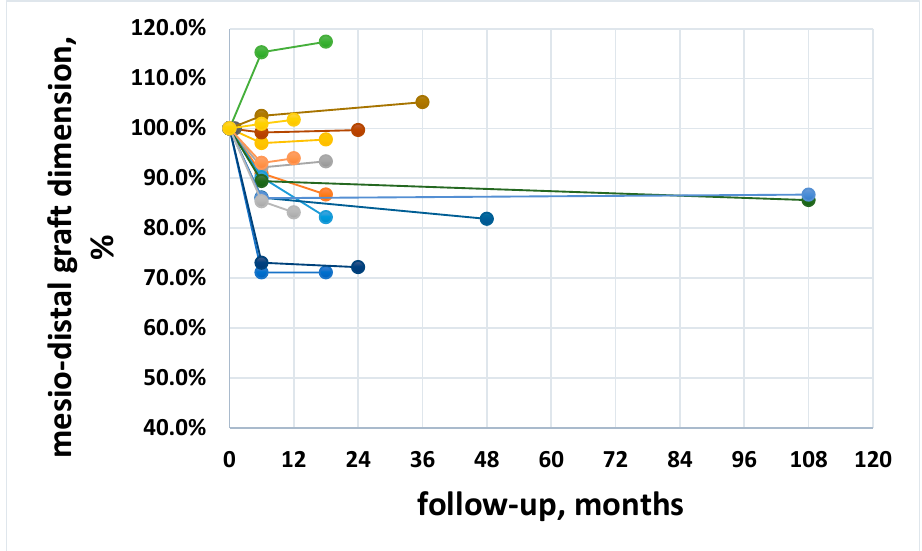
Figure 2. Trend of the mesio-distal dimension along follow-up for all patients, expressed in percentage. Different color lines represent different patients.